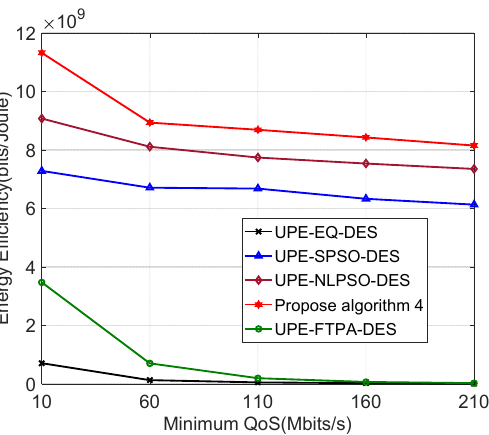
Figure 9. Tradeoff between the energy efficiency and the minimum QoS for joint algorithm.